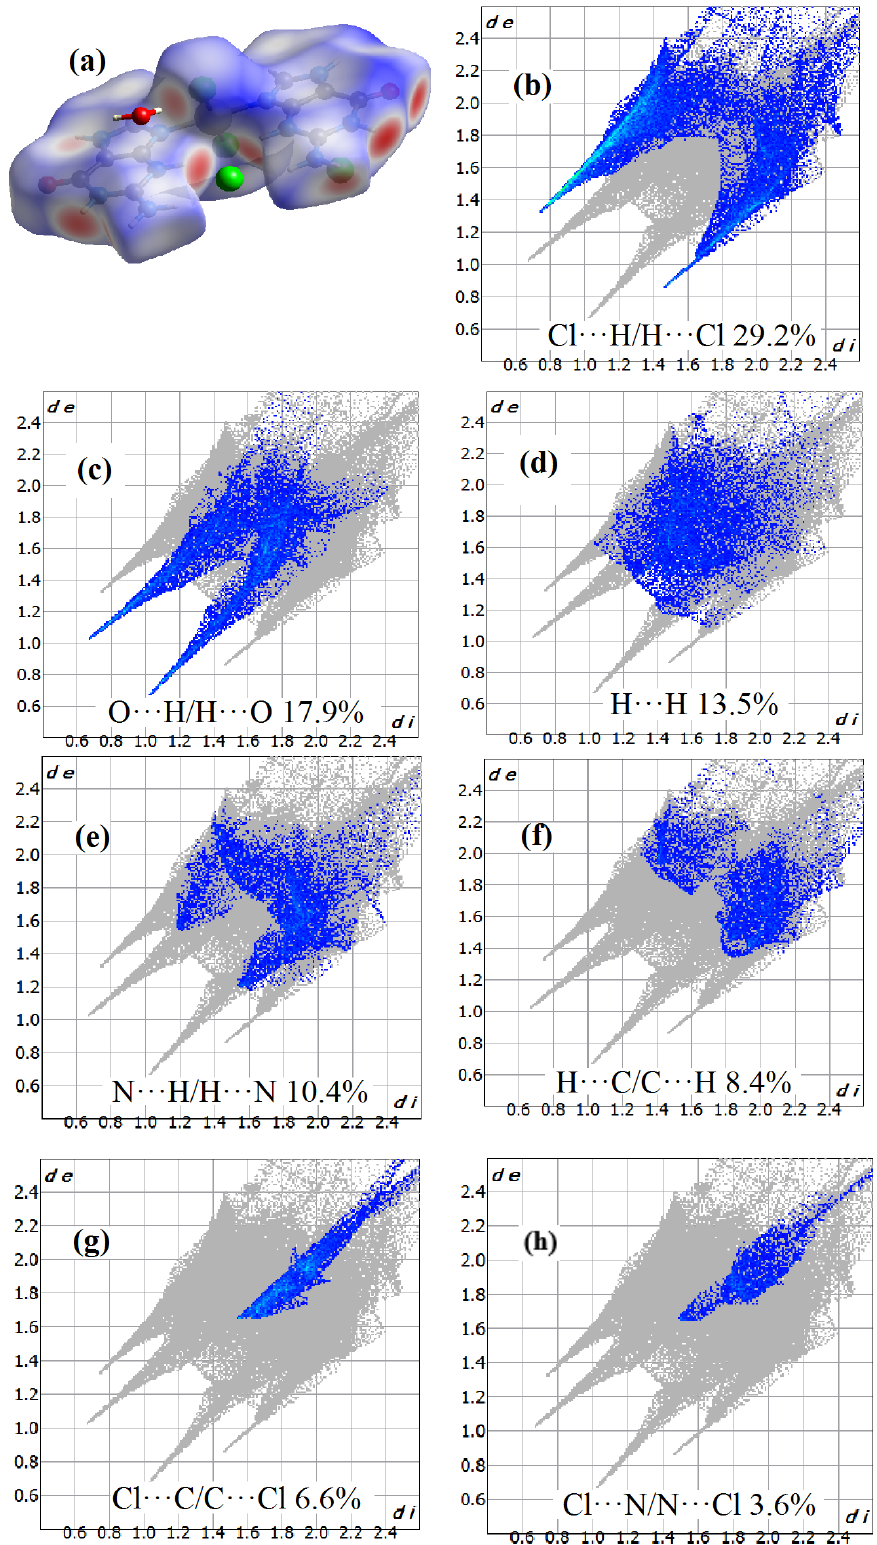
Figure 5. ( a ) Hirshfeld surface d norm for complex 1 and ( b ) two-dimensional fingerprint plot for Cl · · · H/H · · · Cl, ( c ) O · · · H/H · · · O, ( d ) H · · · H, ( e ) N · · · H/H · · · N, ( f ) H · · · C/C · · · H, ( g ) Cl · · · C/C · · · Cl, ( h ) Cl · · · N/N · · · Cl contacts. Surface color scale: red (distances shorter than sum of vdW radii), through white to blue (distances longer than sum of vdW